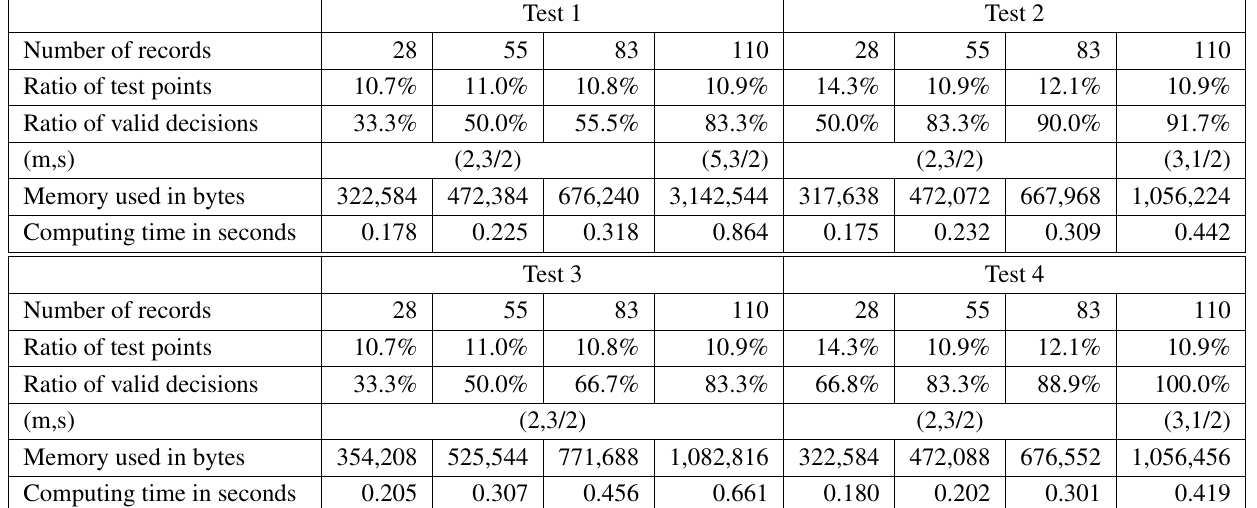
Table 6. Conformity test and algorithm performance results for athlete-1.